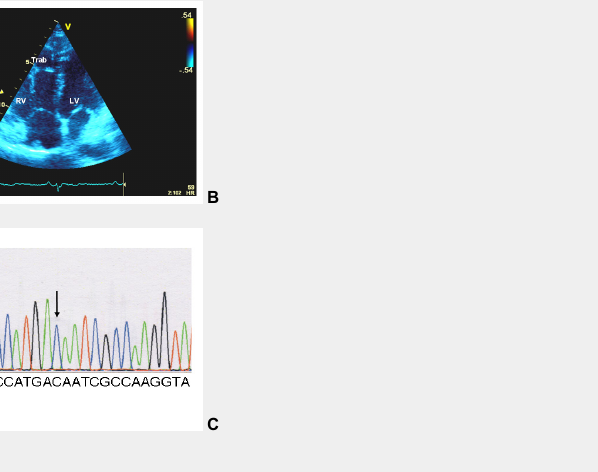
Transthoracic echocardiography, and genetic screening of case 2. A Parasternal short axis view. Right atrium and right ventricular infundibulum are indicated. The right ventricular infundibulum diameter is measured at the level of the aortic valve. RA = right atrium; RV = right ventricular infundibulum. B Apical four chamber view. Right ventricular trabeculations are visible at the free wall level. RV = right ventricle; Trab = trabeculations; LV = left ventricle. C Electrophoregrams of the desmoplakin mutation and of wild type: a heterozygous variant in DSP , c.1691 C>T, was identified, resulting in the missense mutation p.Thr564Ile at a heterozygous